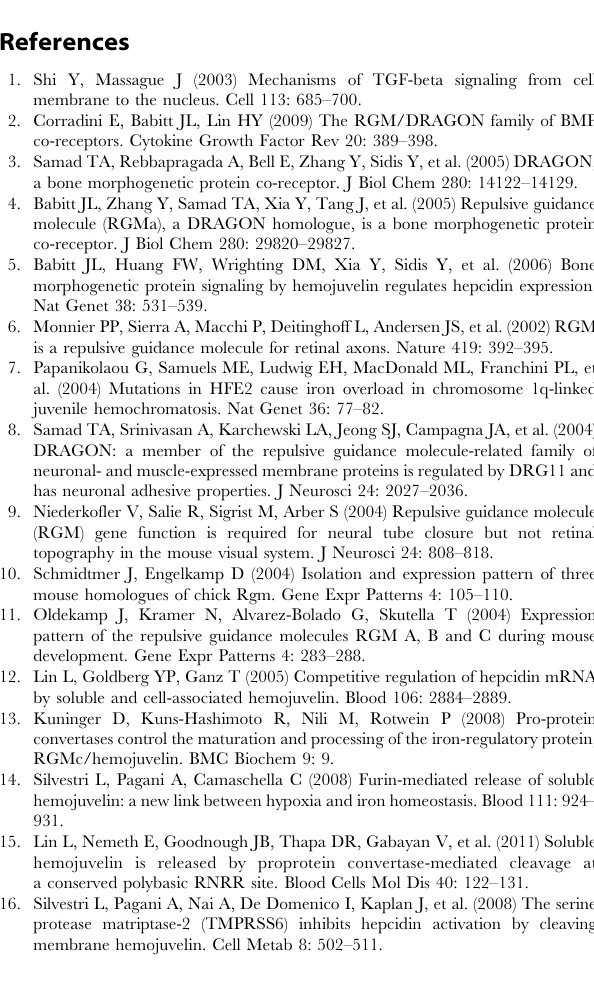
Figure S6 Representative sensograms of kinetics ex- periments between BMP9 and RGM proteins, and BMP9 binding to ALK1-Fc by SPR. (A) HJV protein was diluted in running buffer HBS-EP + into a series of concentration (10, 25, 50, 100 and 200 nM) and injected through CM5 chip immobilized with BMP9 at a density of 139.1 RU. (B) RGMB protein was diluted in running buffer HBS-EP + into a series of concentration (2, 4, 8, 15 and 30 nM) and injected through CM5 chip immobilized with BMP9 at a density of 160.7 RU. (C) RGMA protein was diluted in running buffer HBS-EP + into a series of concentration (6, 12, 25, 50 and 100 nM) and injected through CM5 chip immobilized with BMP9 at a density of 160.7 RU. (A– C) No significant binding was detected and kinetics data cannot be calculated. (D) ALK1-Fc protein was diluted in running buffer HBS-EP + into 100 nM and injected through CM5 chip immobilized with BMP9 at a density of 160.7